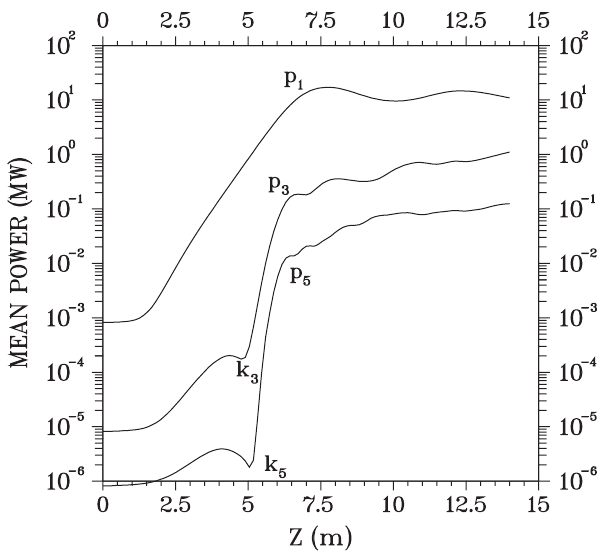
FIG. 6. Evolution of the first three harmonics for SPARC-like